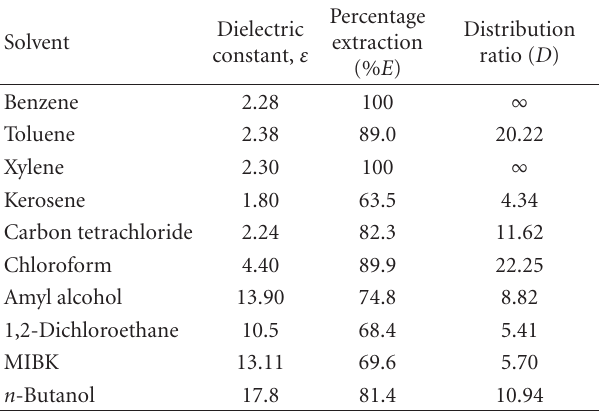
Table 3: Extraction behaviour of neodymium(III) as a function